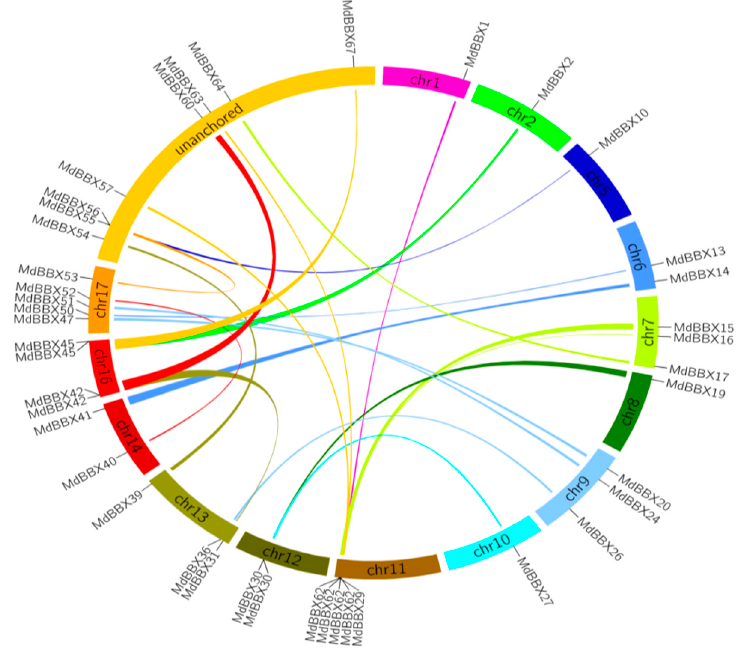
Figure 5. Segmental duplication of apple BBX genes. Genomic locations and duplicated BBX gene pairs in apple. Gene pairs located in the segmental duplicated chromosomal regions are linked using different lines.